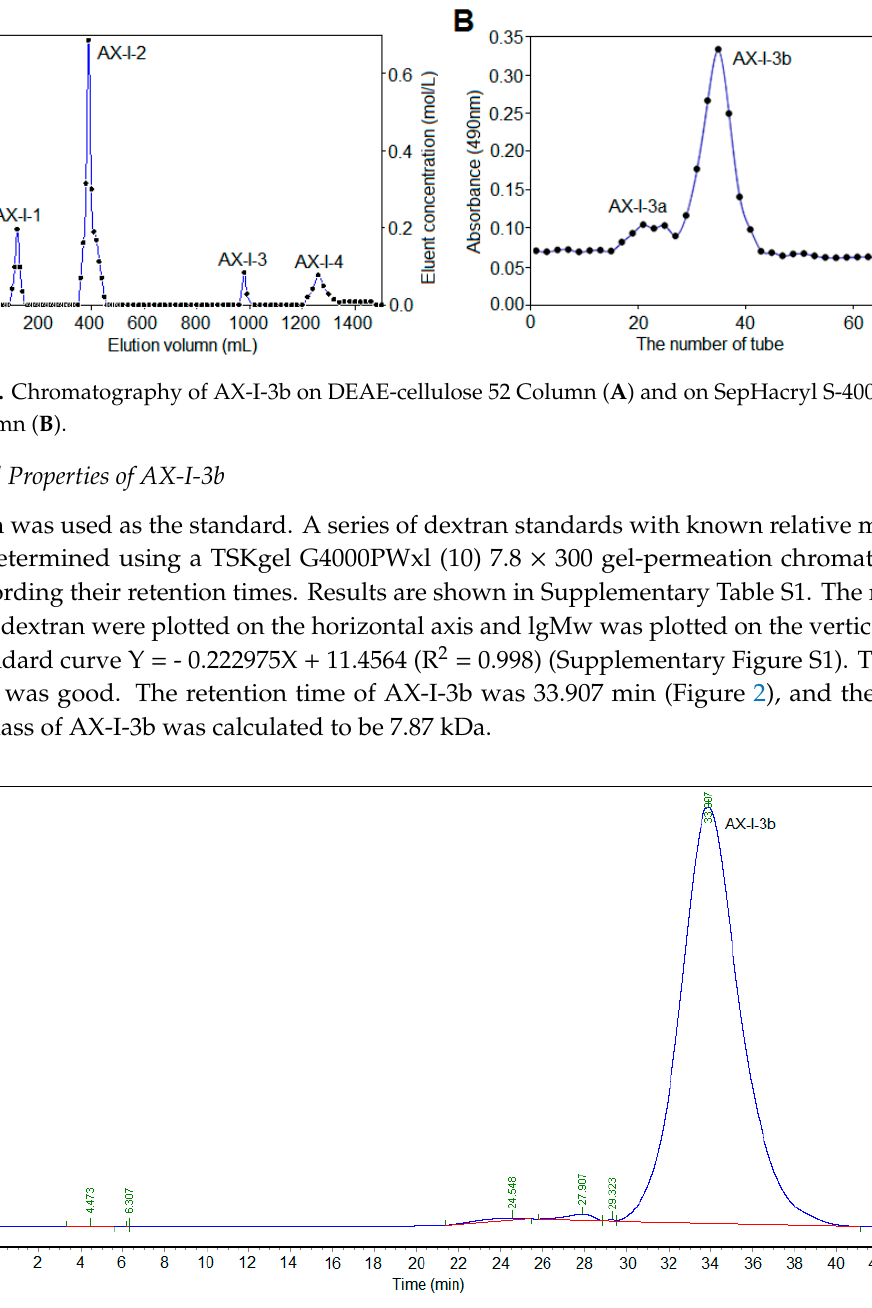
Figure 2. High-performance gel chromatogram of AX-I-3b. The monosaccharide composition of AX-I-3b was analyzed by GC-MS. The total-ion current diagram is shown in Figure 3. Comparing to the retention times of the monosaccharide references, the polysaccharide AX-I-3b contained arabinose (Ara; retention time t R = 25.51 min), xylose (Xyl; t R = 26.25 min), and glucose (Glc; t R = 33.41 min), at a molar ratio of 10.4:79.3:1.1 (Supplementary Table S2).